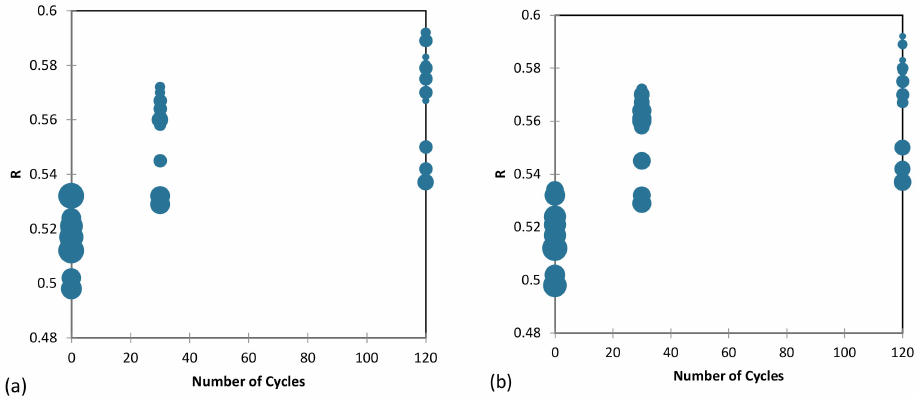
Figure 18. Effects of cycling loading on ( a ) e min and ( b ) e max based on the roundness R